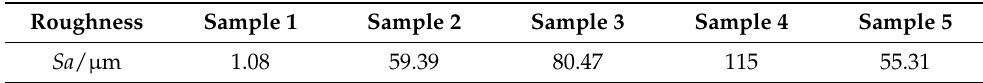
Figure 9. 3D surface topography with different roughness: 1.08 µm ( a ), 59.39 µm ( b ), 80.47 µm ( c ), and 115 µm ( d ). Table 1. Surface roughness parameters of AZ80 magnesium alloy.